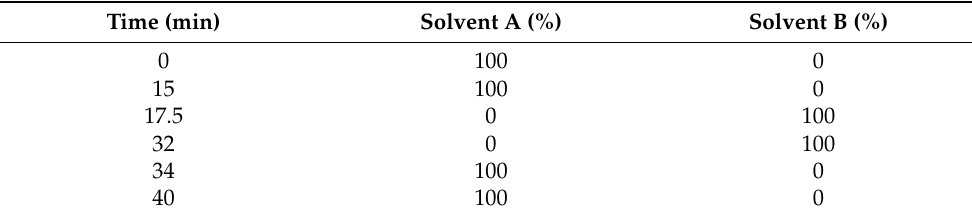
Table 1. Gradient elution used for HPLC analysis of chlorophylls a and b and the carotenoids neoxanthin, lutein, violaxanthin, antheraxanthin, and β -carotene. Time